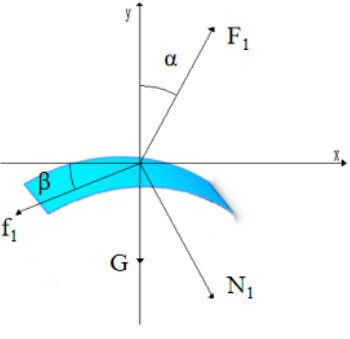
Figure 6. Schematic diagram of soil separation plate structure. N 1 —the force of diversion surface on soil particles, N; f 1 —the friction force between the diversion surface and soil particles, N; F 1 —the normal force of trench cutter on soil particles, N; G — the gravity of soil particles, N.